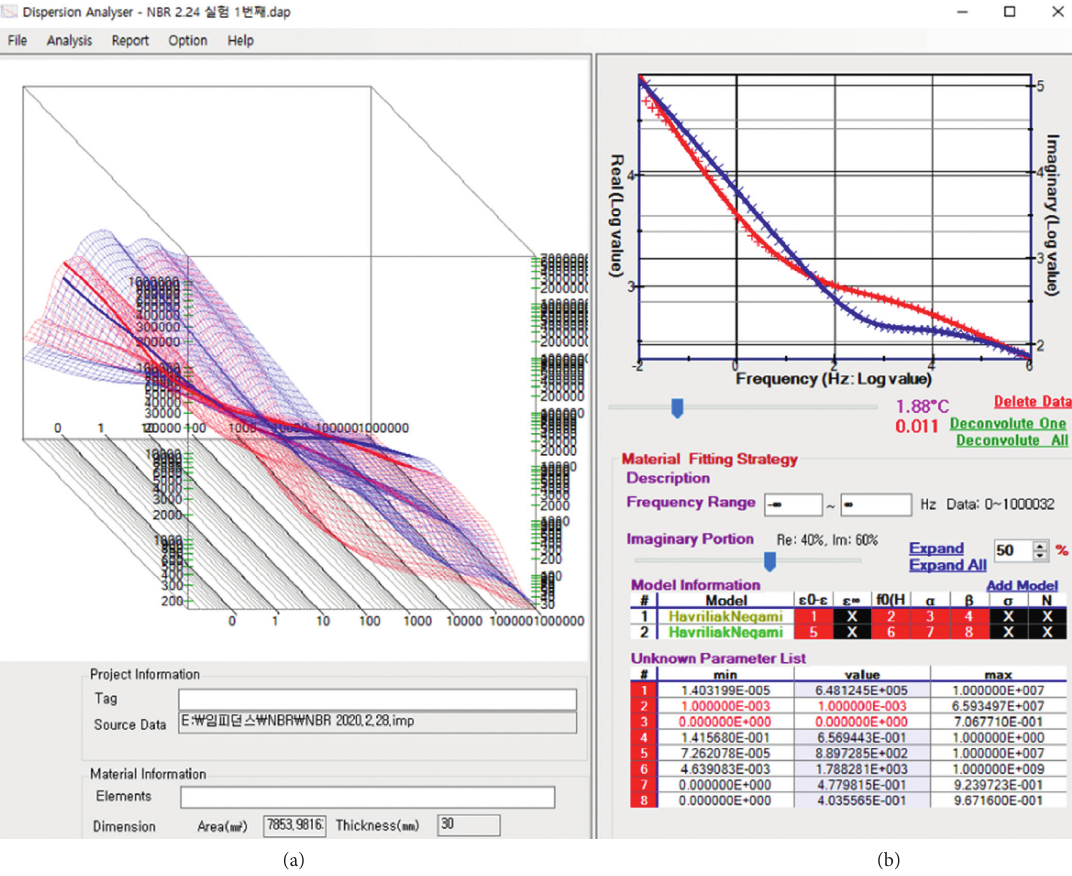
Figure 3: An example of the decomposition of two relaxation processes in NBR by the dispersion analysis program at 275K. (a) Real (red line) and imaginary (blue line) fitted permittivity values versus the frequency for all temperatures and (b) the decomposition of the two relaxation processes by the dispersion analysis program. In (b), the measured real (red × ) and imaginary (blue × ) permittivity and the fitted real (red line) and imaginary (blue line) permittivity graphs at 275 K are shown, and their fitted parameters are listed at the bottom